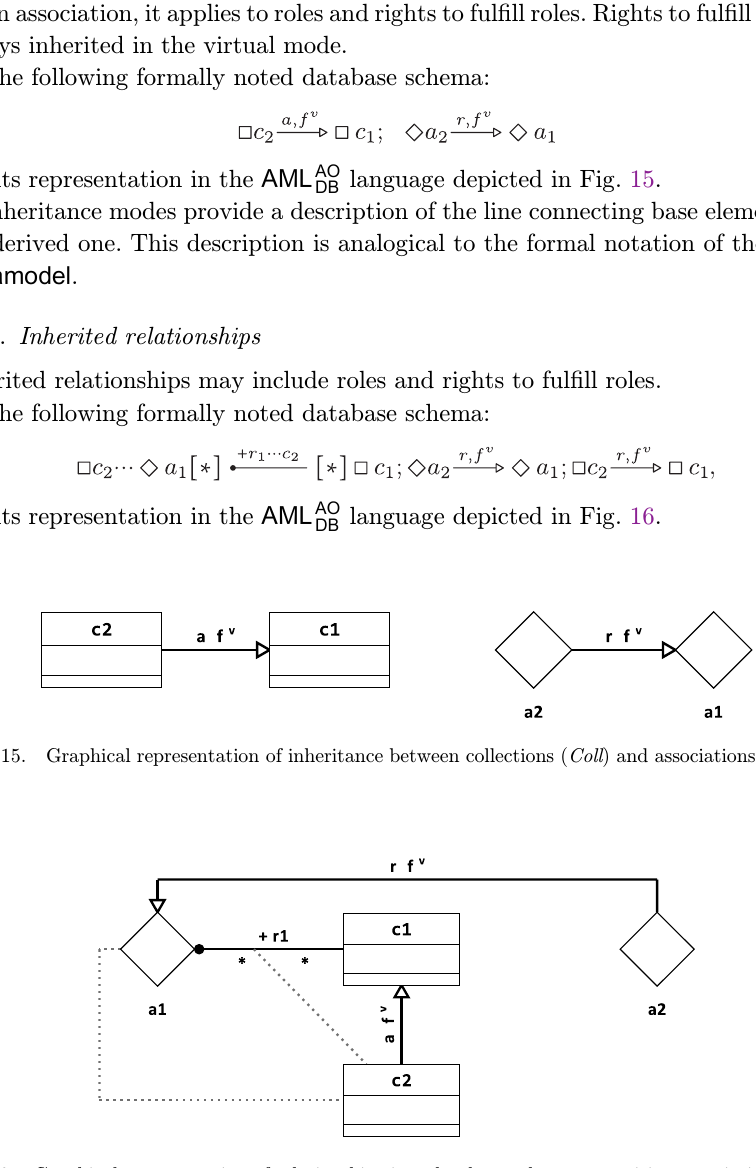
Fig. 16. Graphical representation of relationships in a database schema comprising association ( Assoc ) and collection ( Coll ) inheritance.